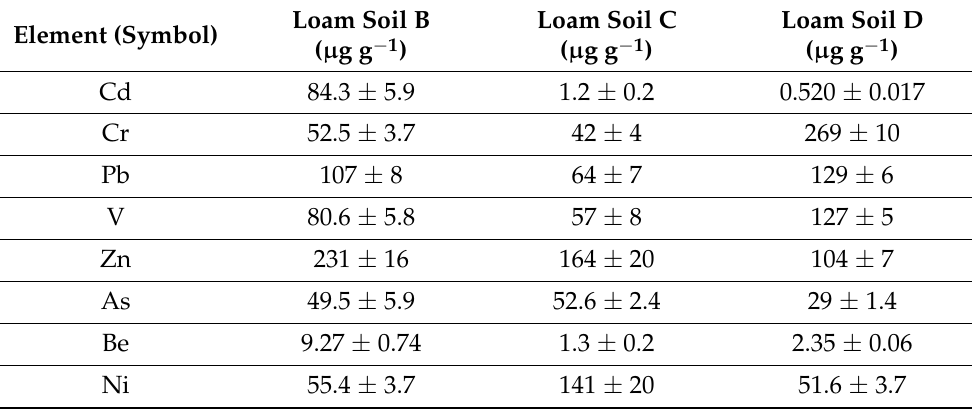
Table 1. Concentrations of investigated traces present in loam soil samples of certified reference material